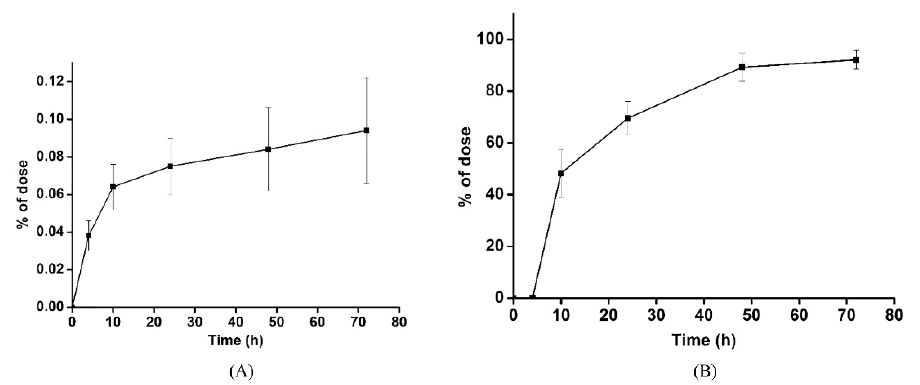
Figure 4. Cumulative amounts of LBP-FITC excreted in urine ( A ) and feces ( B ) after an oral dose of 50 mg/kg to rats. Table 7. Urinary and feces excretion rate of LBP-FITC after an oral dose of 50 mg/kg to